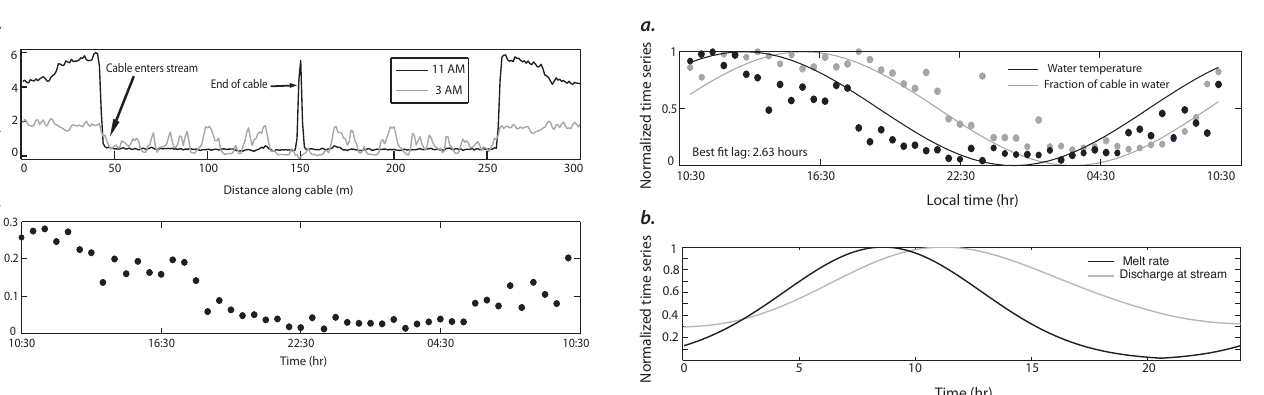
Fig. 5. (a) Unfiltered DTS temperature trace at 11:00local time (black curve) and 03:00local time (grey curve). The cable runs from the sensor to a water bath (not plotted), over glacier ice to the stream. The point of cable entry into the stream and end of cable (these are double-ended measurements, so trace is symmetric about midpoint) are labeled. (b) DTS time series over 24h on a clear day, filtered spatially and averaged for water temperature. Each point is the 30min average temperature along the submerged length of the cable.